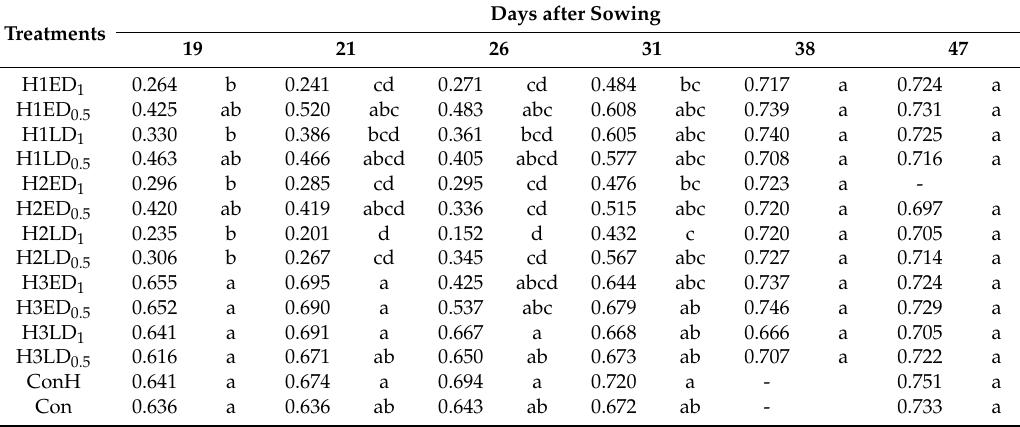
Table 2. The results of chlorophyll fluorescence measurements (Fv/Fm means) of the greenhouse experiment. H1, herbicide combination 1; H2, herbicide combination 2; H3, herbicide combination 3; E, early application; L, late application; D 1 , recommended dosage; D 0.5 , half recommended dosage; ConH, control with hand weeding; Con, control without hand weeding; significant differences between mean values are indicated by different letters (Tukey’s HSD Test, p <